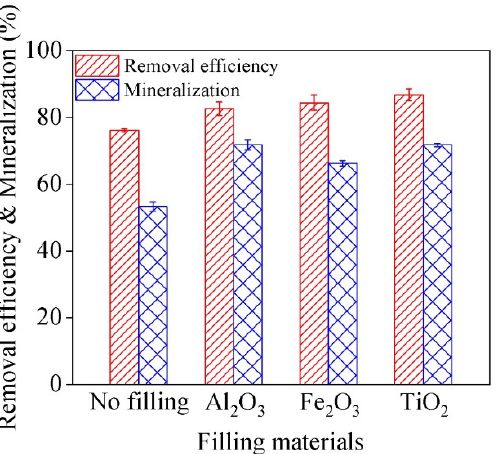
Figure 4. The removal efficiency and the mineralization of naphthalene under different filling materials. (Applied voltage: 24 kV; driving frequency: 12.6 kHz; initial naphthalene concentration: 21.5 ppm; total gas flow rate: 500 mL/min; discharge gap: 3 mm).